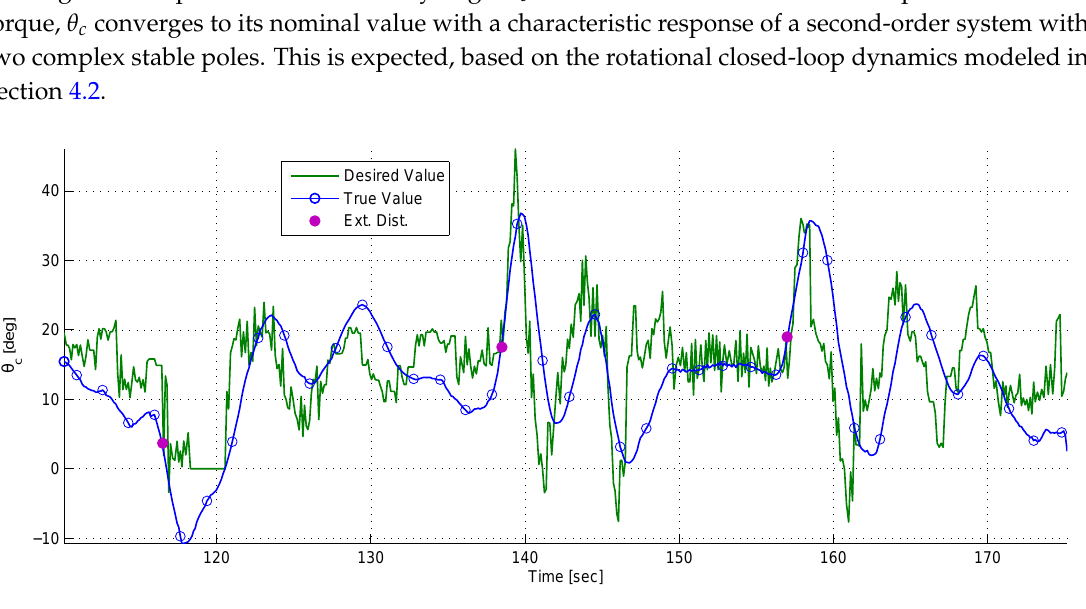
Figure 15. A comparison between the true body angle and the desired body